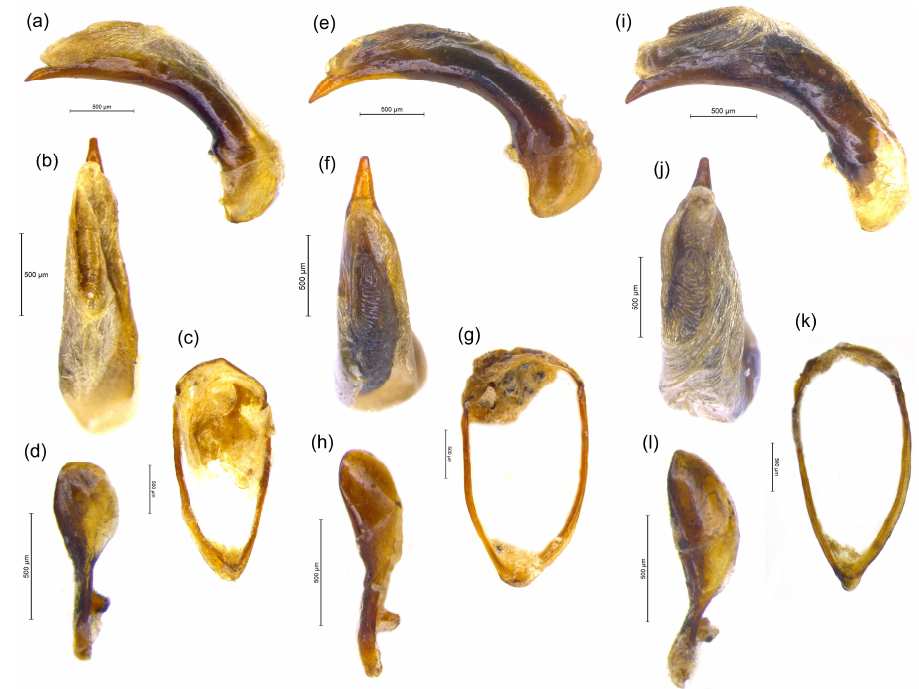
Figure 12. Male genitalia: The median lobe of the aedeagus is in lateral and dorsal view, IX invaginated segment and right paramere of: ( a – d ) P. erythrocephalus ; ( e – h ) P. simonisi n. sp .; ( i – l ) P. complanatus .